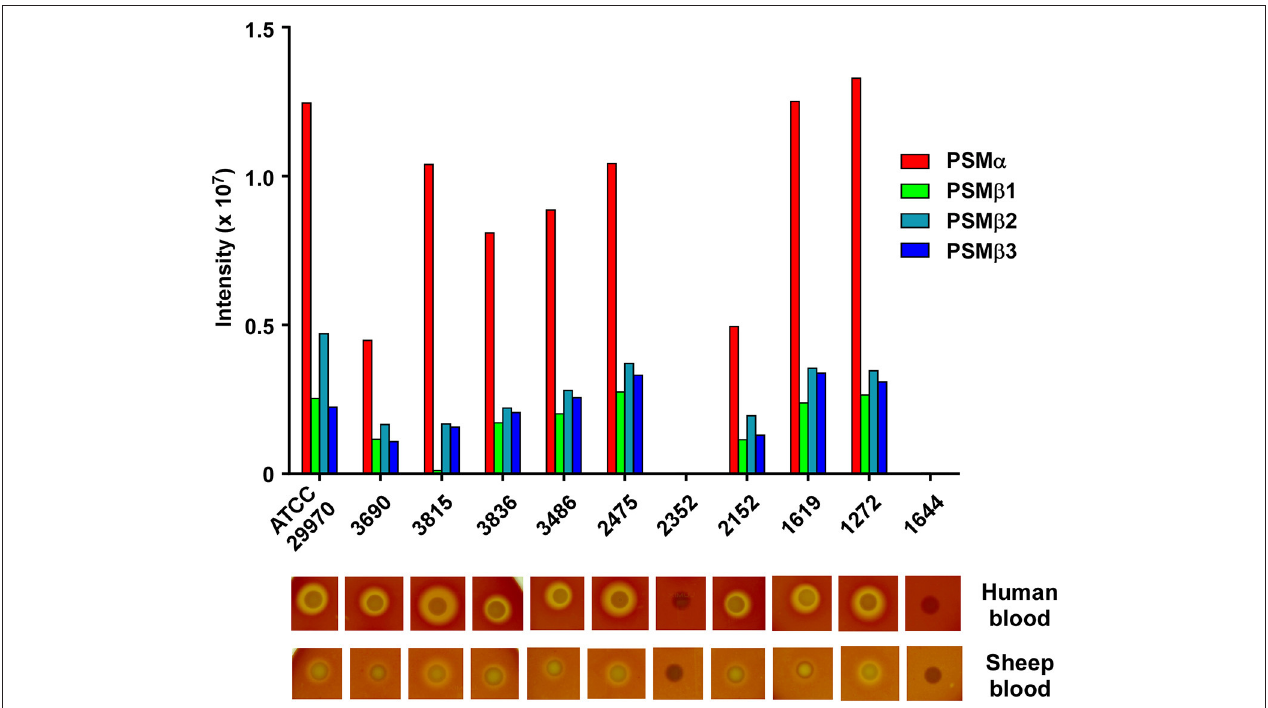
FIGURE 5 | Production of S. haemolyticus PSMs is conserved among different isolates and correlates with hemolytic capacity. Stationary-phase culture filtrates of 11 S. haemolyticus isolates were analyzed by RP-HPLC/MS. Below, hemolytic capacity of isolates is shown. Isolates were analyzed by spotting on human or sheep agar plates and growing overnight in a 37 ◦ C